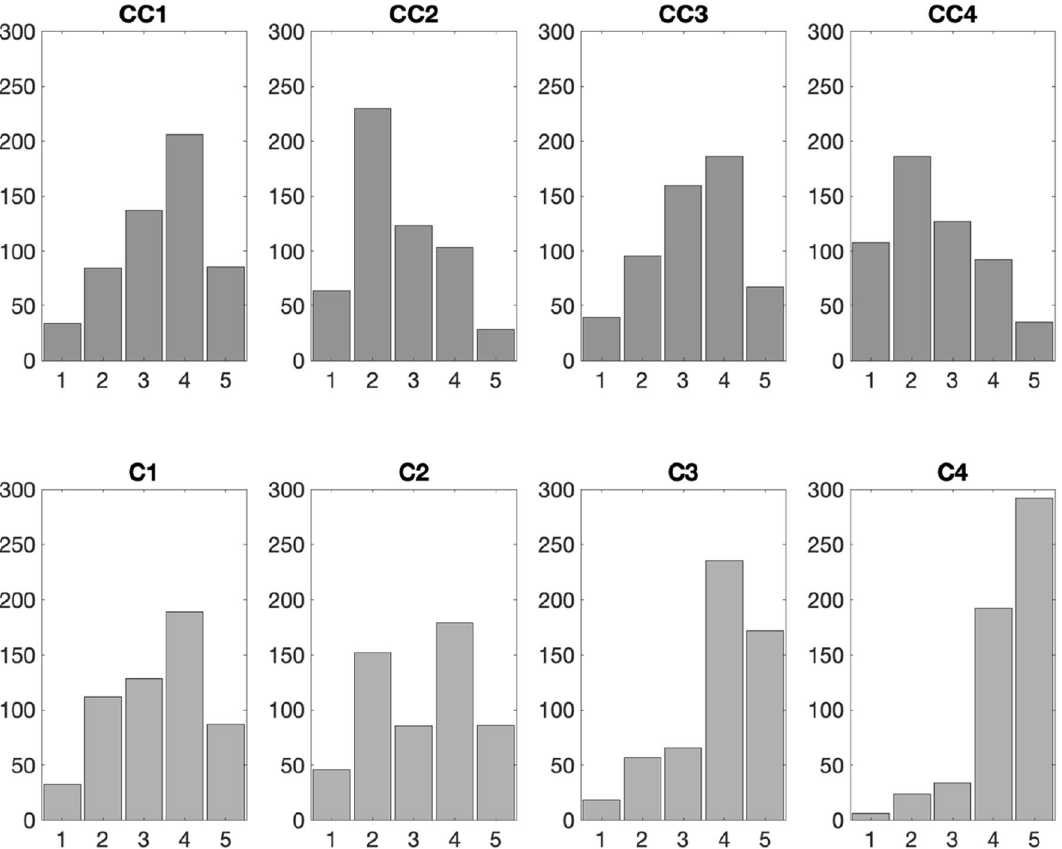
Figure 3. Histograms showing the distribution of responses to the climate change (top row) and COVID-19 (bottom row) related questions. For comparison purposes, the histograms are organised in such a way that corresponding questions related to climate change and COVID-19 are presented in the same column. The questions were rated on a Likert scale from 1 = I strongly disagree to 5 = I strongly agree. For the exact questions’ text, see Table